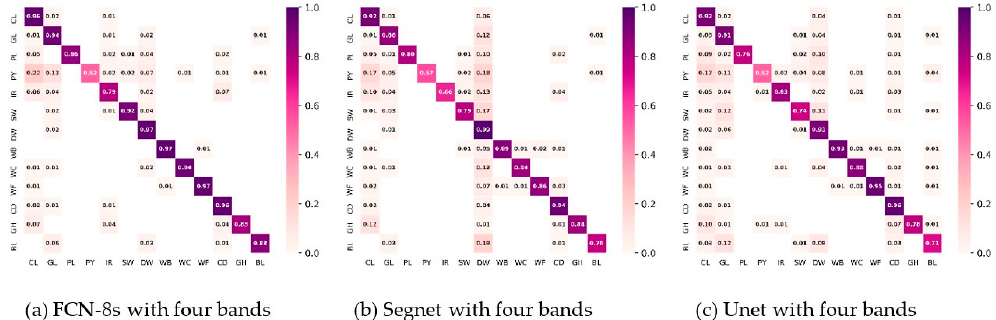
Figure 6. Heatmap visualization of the normalized confusion matrix for land cover classification using four bands input with three models. ( a ) FCN-8s with four bands, ( b ) Segnet with four bands, and ( c ) Unet with four bands. The labeled values on each grid show the normalized accuracy of each class, which indicates the degree of confusion ratio with the other classes. The normalized accuracies greater than 0.01 are labeled. CL represents cereal land, GL represents grassland, PL represents poplar land, PY represents pathway in farmland, IR represents the impervious road, SW represents sparse woods, DW represents dense woods, WB represents water bodies, WC represents the waterless channel, WF represents water conservancy facilities, CD represents construction land, GH represents greenhouse, and BL represents bare land.